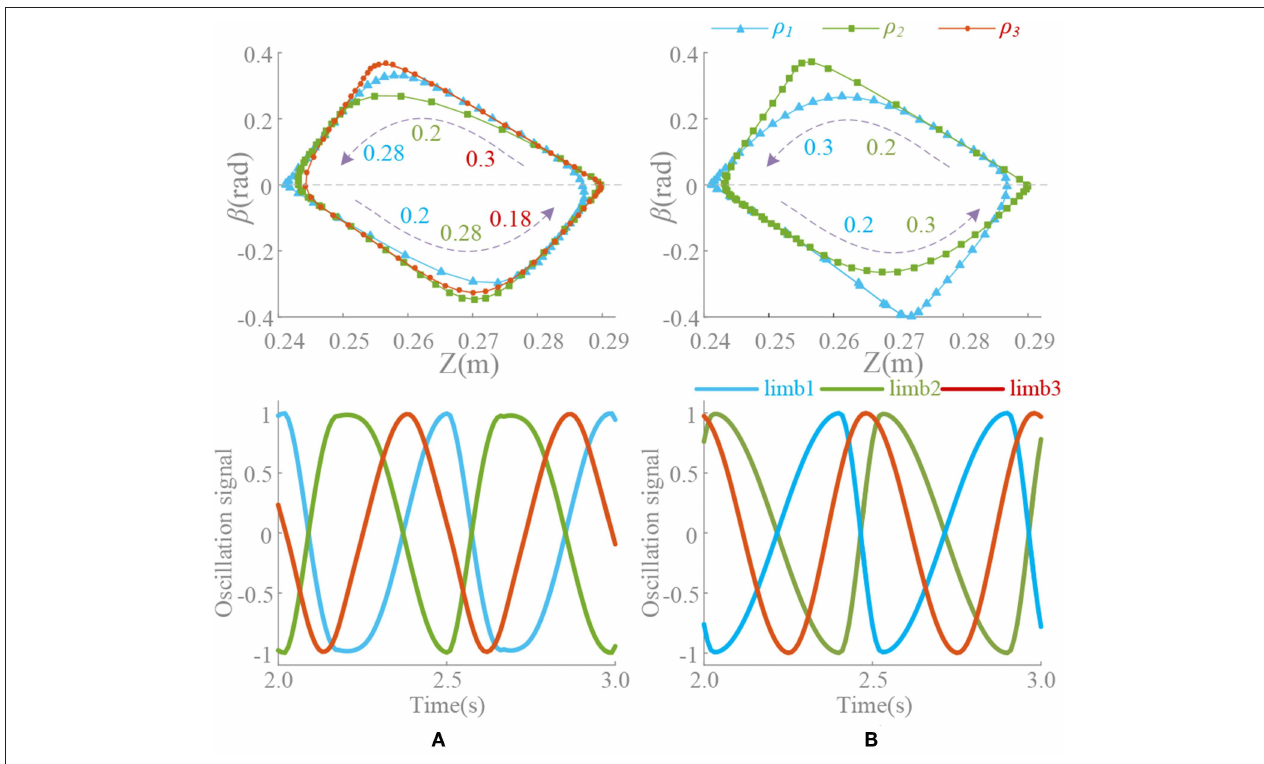
FIGURE 9 | Position trajectory and waveform of coupling motion. T = 0.5s, ψ = [0, 0.5, 0.2, 0.3, 0, 0.5], ρ 1 = [3/4, 1/4, 0.55, 0.45, 3/4, 1/4], ρ 2 = [1/4, 3/4, 0.45, 0.55, 1/4, 3/4], ρ 3 = [3/4, 1/4, 3/4, 1/4, 3/4, 1/4]. Forward duration (below zero line) and back duration (above zero line) are influenced by ρ limb 3 , which is corresponding to limb 3 and 1 13 . β is the pitch angle round Y. (A) Constant coupling strength, k ( t ) = 5. (B) Proposed coupling strength k ( t ) = k e ( t